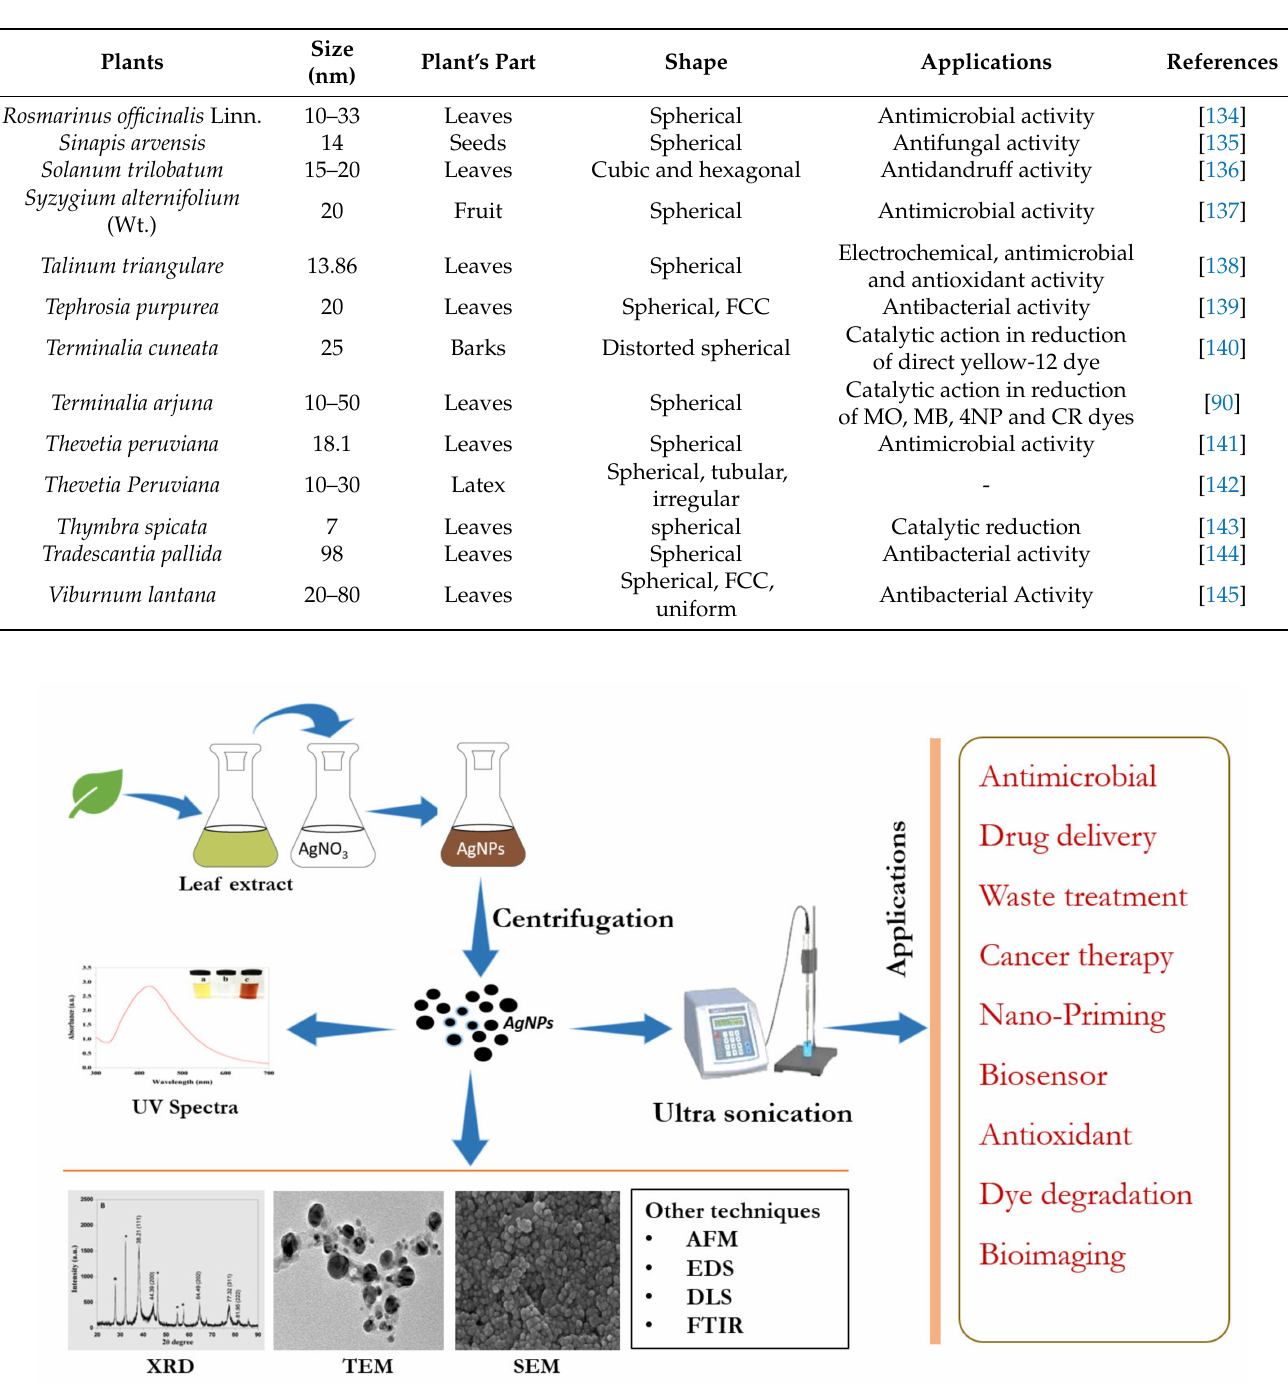
Figure 2. Graphical representation of the mechanism of plant-mediated synthesis of silver nanoparti- cles and their